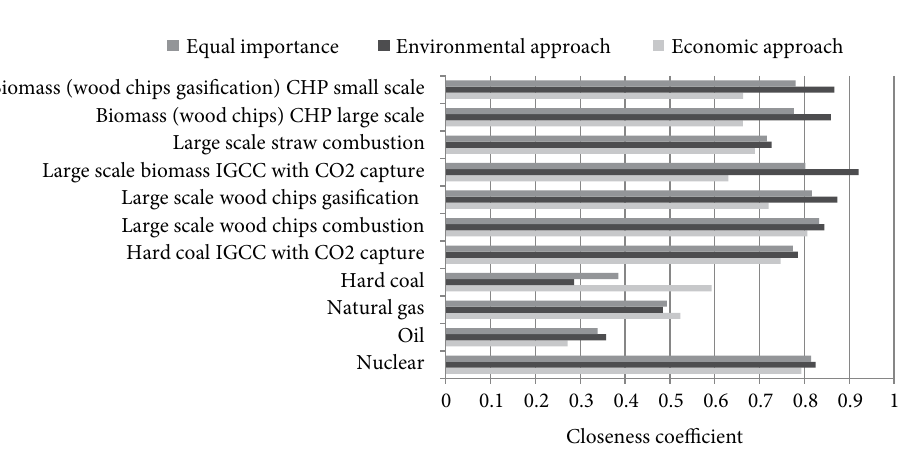
Fig. 1. Impact of different weighting schemes on summarized assessment of energy technologies in electricity generation The results of analysis imply that the ranking of electricity generation technologies varies across the approaches employed in the analysis. Therefore it is important to quantify the underlying factors of discordance. Thus, Pearson correlation coefficients were obtained to measure the linear relationships between closeness coefficients provided by the three approaches as defined above. Similarly, Spearman rank correlation coefficients were estimated for ranks attributed to the electricity generation technologies according to the three approaches. The results of correlation analysis are presented in Table